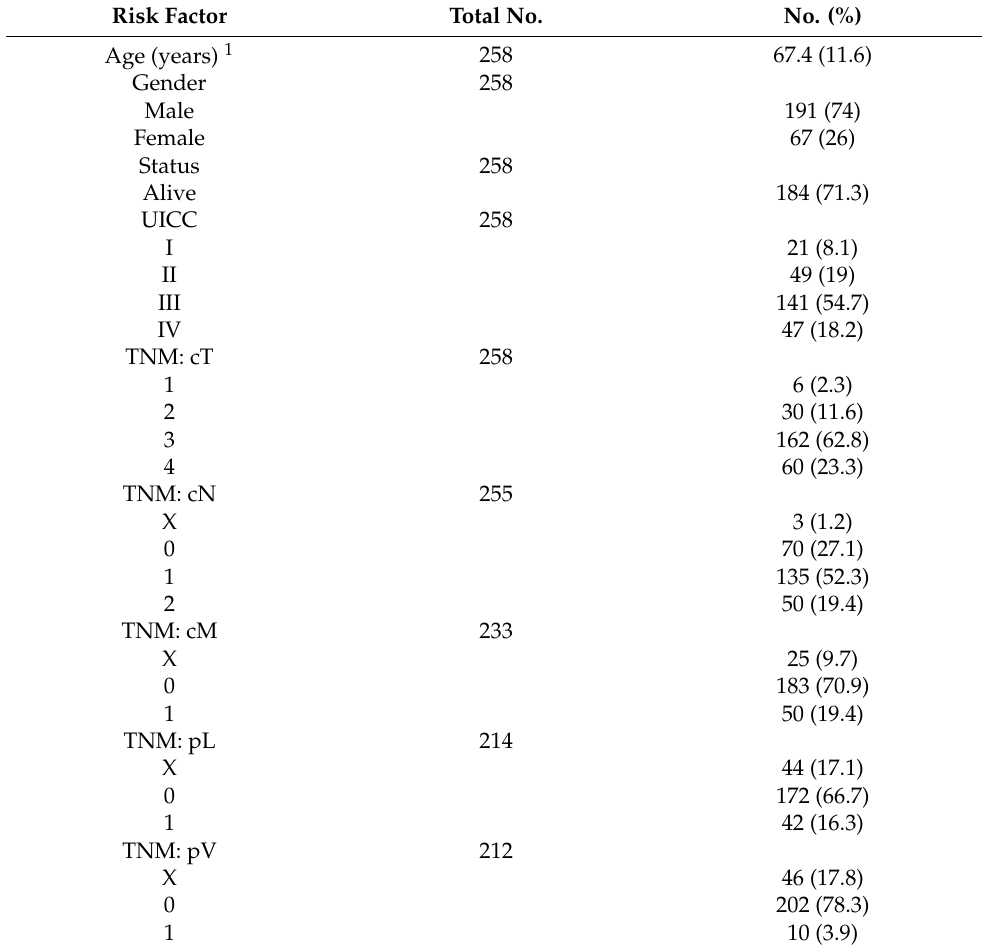
Table 1. Demographic and basic disease